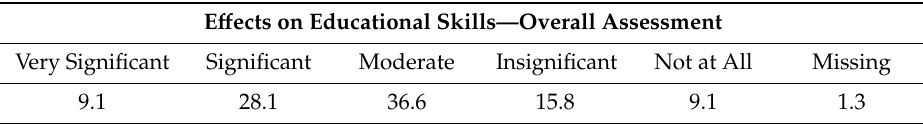
Table 7. Overall assessment of the e ff ects on educational skills.